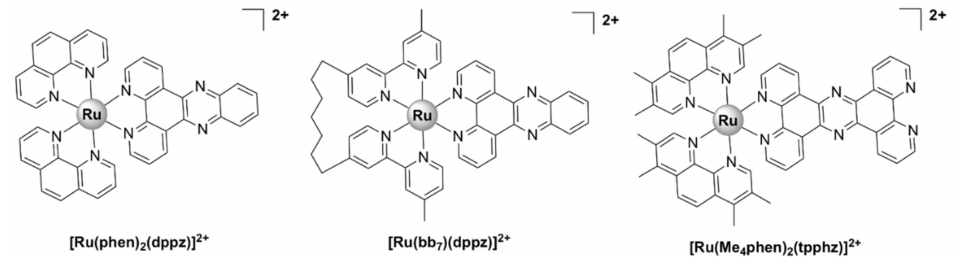
Figure 8. Chemical structures of heteroleptic Ru (II) complexes bearing pyridophenazine